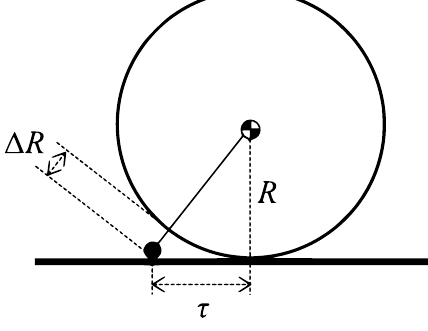
Figure 9. Shift of the contact